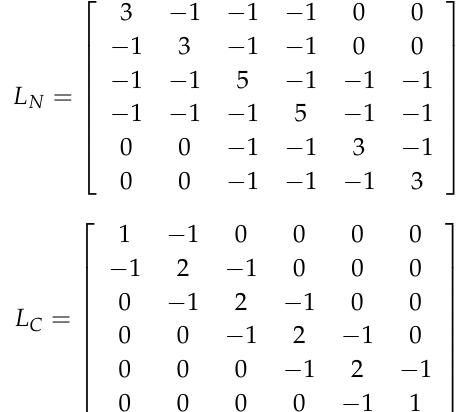
Figure 12. Communication topology of the chain connection.